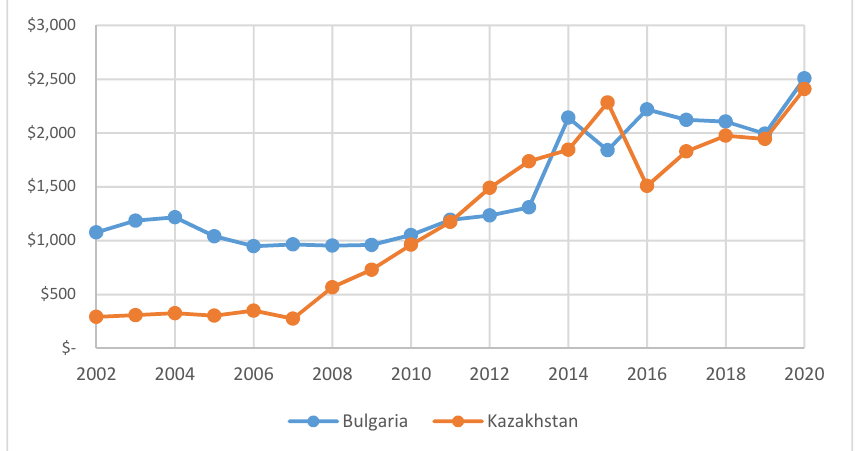
Figure 4. Government debt per capita (USD) Kazakhstan vs. Bulgaria. Source: Created by the authors based on data https://countryeconomy.com.